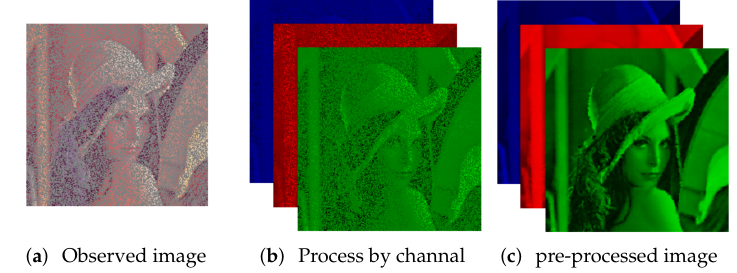
Figure 1. Pre-process observed image by channel.